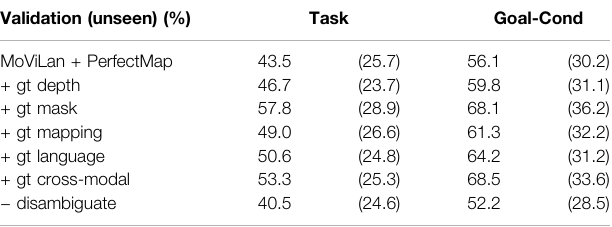
TABLE 3 | Ablation study on validation unseen dataset. Validation (unseen) (%)